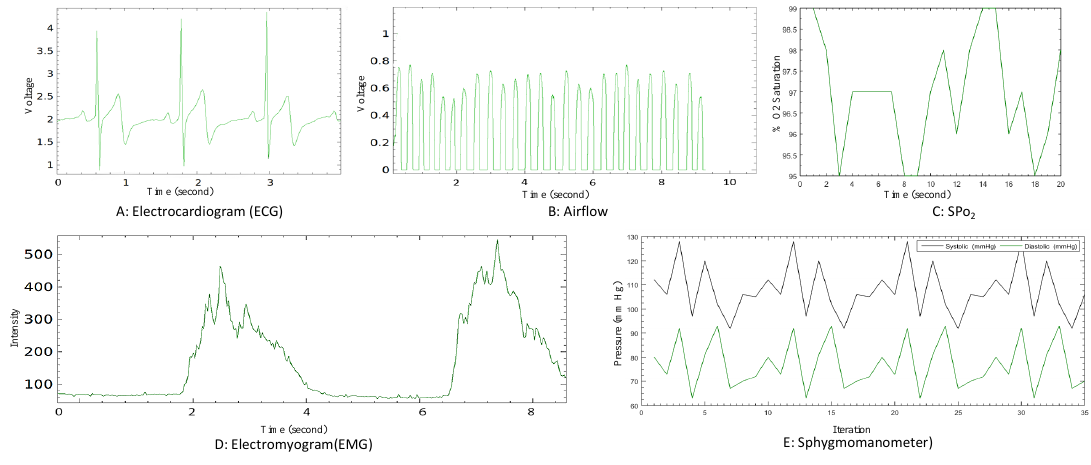
Figure 8. Vital-sign reading with different